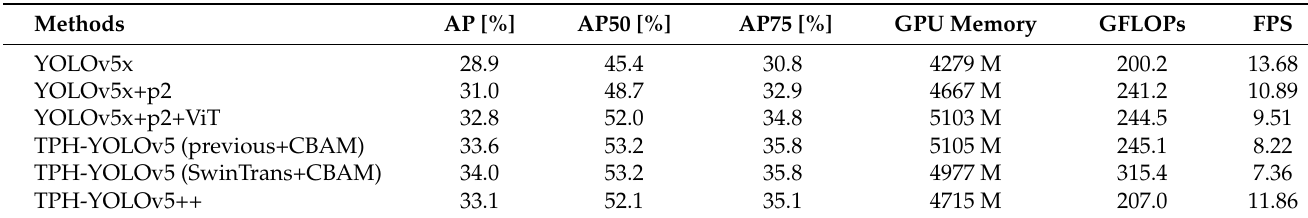
Table 5. Ablation study of the importance of each proposed component on the VisDrone2021 test-dev set. ‘p2’ denotes the additional prediction head. ‘ViT’ denotes the ViT module. ‘previous’ denotes the ‘YOLOv5x+p2+ViT’, and ‘TPH-YOLOv5 (SwinTrans+CBAM)’ denotes the model replacing all ViT modules with Swin-Transfomer.